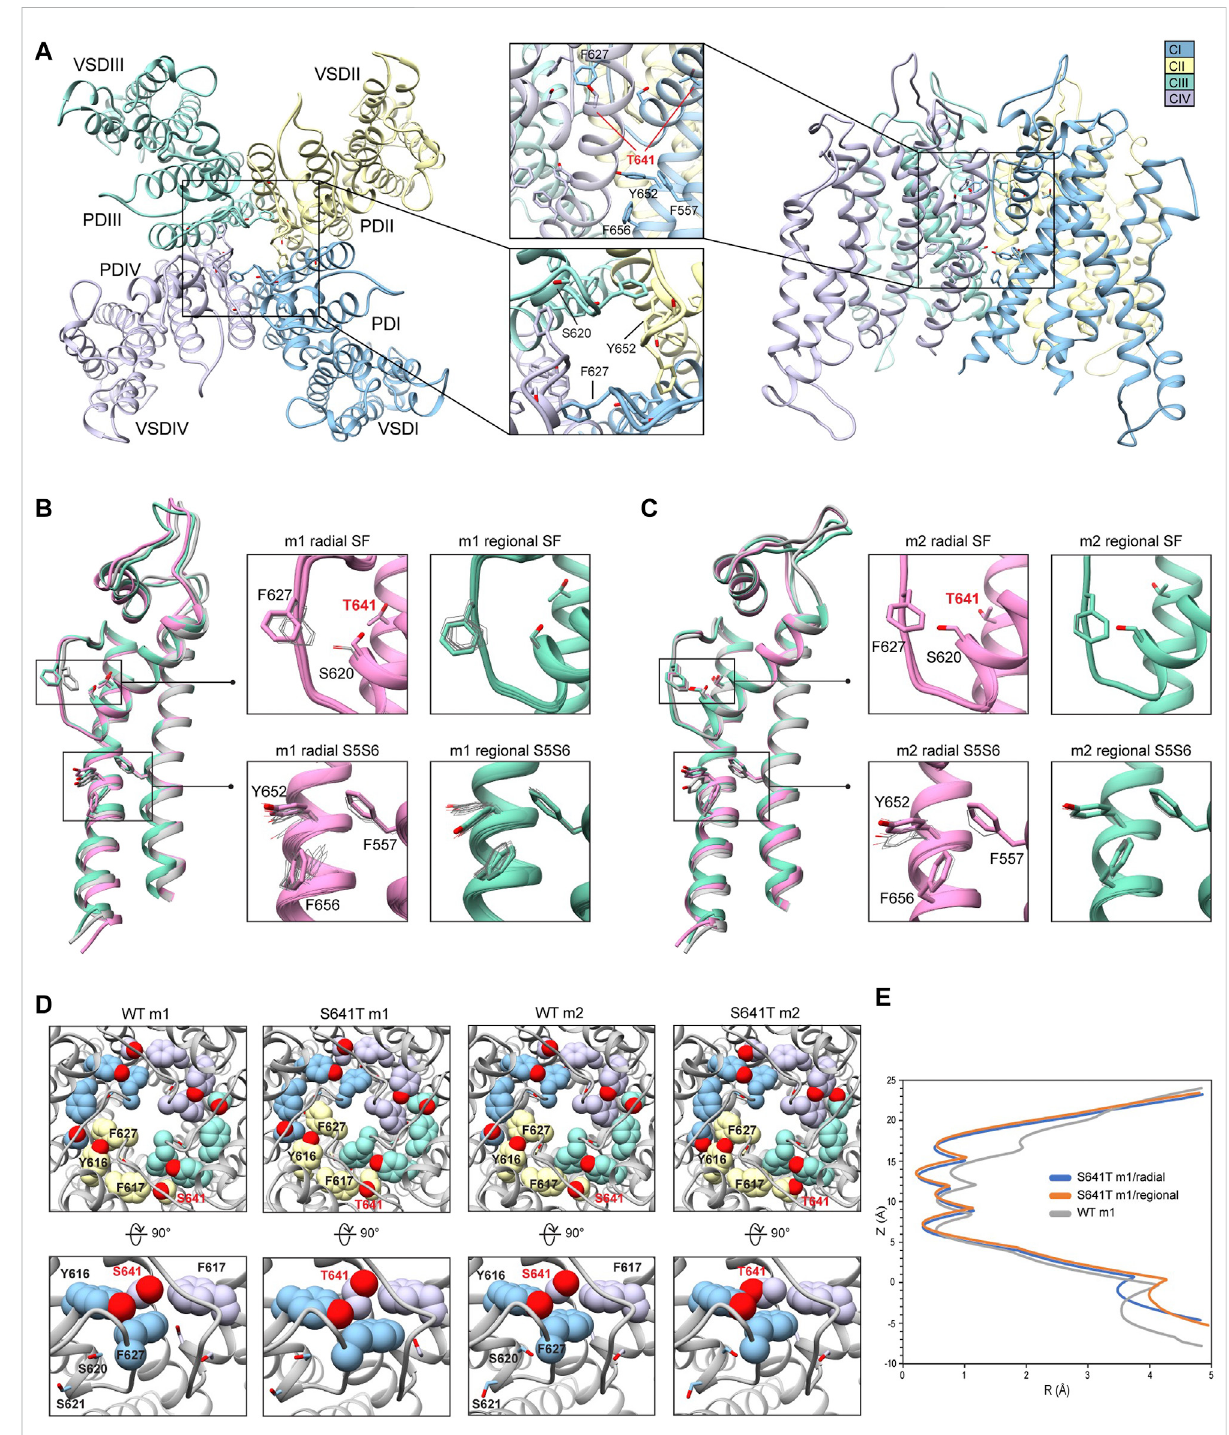
FIGURE 5 hERGS641T model1(m1)andmodel2(m2)comparison. (A) DomainstructureofhERGS641Tmutantmodels. Chains arecoloredaccordingto the legend. PD, pore domain; VSD, voltage sensing domain. Chain I is colored in blue, chain II is colored in yellow, chain III is colored in green, and chainIViscoloredinviolet. (B) OverlayofhERGS641Tm1modelsusingtheradial(rad,pink)andregional(reg,green)movemaps.WTmodelstructure is in gray. Single domain overlay shows top-scoring structures, whereas inset details show top 50 structures. Top structure in inset detail is shown asstick, with remaining structures shown as graywires.Mutant residueislabeled inbold red. (C) OverlayofhERGS641Tm2modelsusingthe radial (rad, pink) and regional (reg, green) movemaps. Depictions are identical to (B) (D) Comparison of residue641 (labeled bold red) and associated residuepositionssurroundingtheselectivity fi lter(SF)forhERGWTandS641Tm1/m2models.Toprow:topviewofhERGchannelpore,bottomrow: side-view of S/T641 interaction details. Residues are shown as spheres and colored as in Figure 2. (E) Pore radii generated by the HOLE program for hERG S641T m1 radial (blue) and regional (orange) as well as WT m1 (gray)